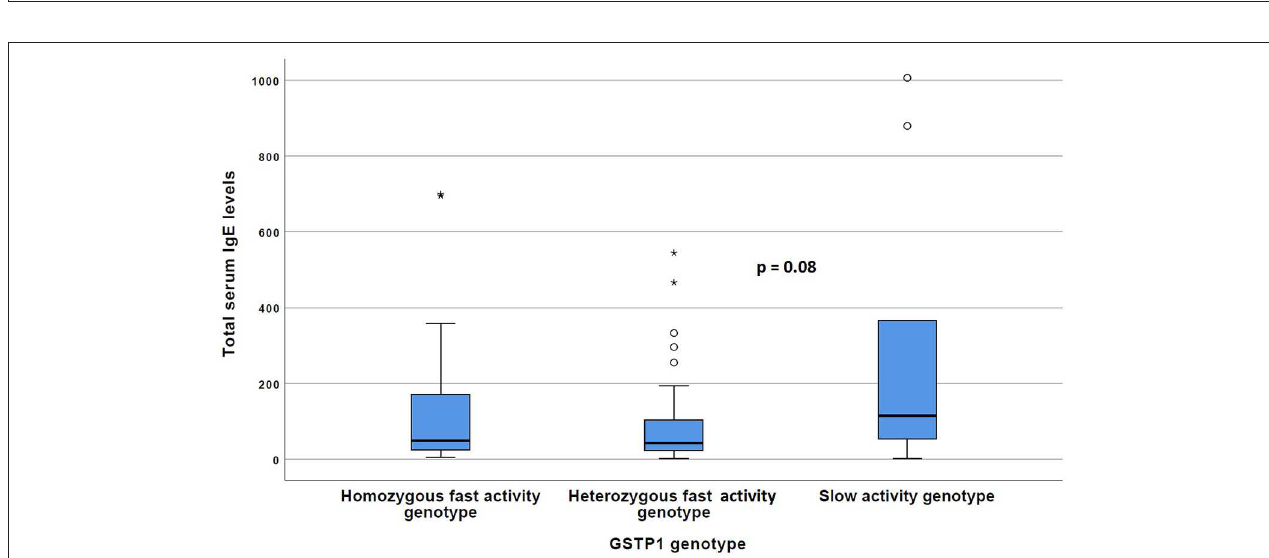
FIGURE 1 | The Serum IL-13 levels of the patients with GSTP1 slow activity genotype compared with those with homozygous fast activity and heterozygous fast activity genotypes. Boxplots with median (line) and respective 25 and 75 percentiles as well as outliers with circles are given. P -value have been received with the Kruskal–Wallis test.